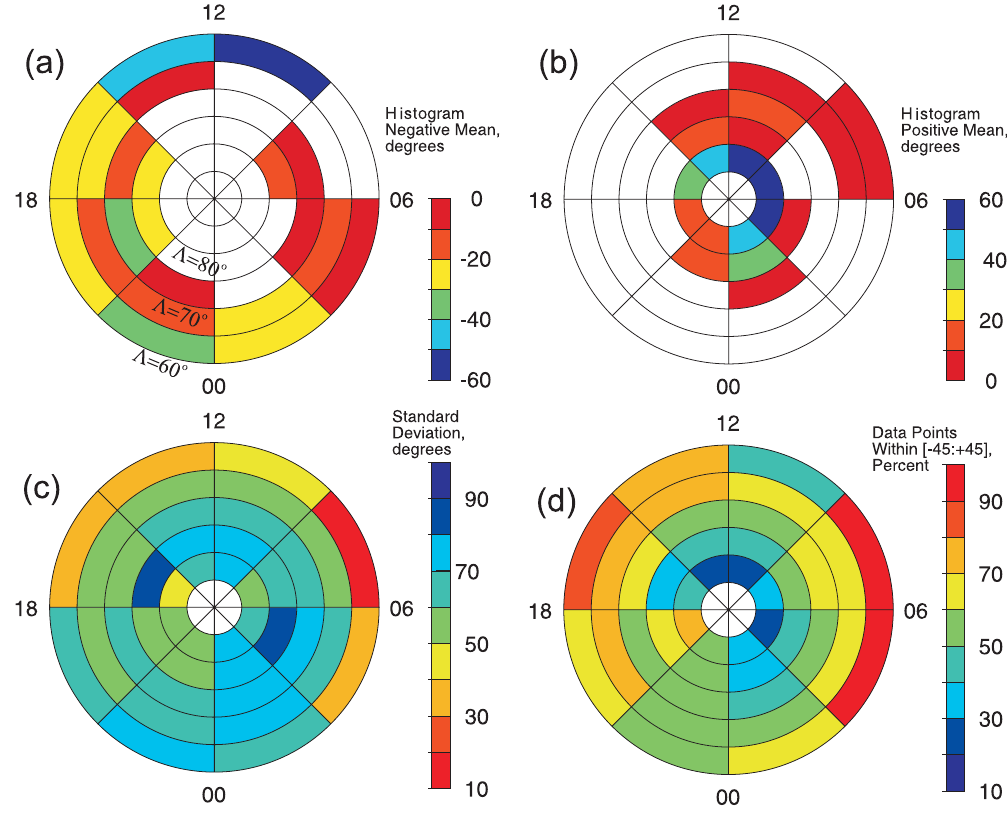
Fig. 7. Color segment diagrams showing parameters of histogram distributions in eight magnetic local time sectors for 5 ◦ steps in the ACCGM latitude (between 60 ◦ and 85 ◦ ): (a) The mean value for negative differences 1θ , (b) mean value for positive differences 1θ , (c) standard deviation for the angle 1θ and (d) the percentage of points with 1θ within ± 45 ◦ . Data for five days in various seasons of 2001 were